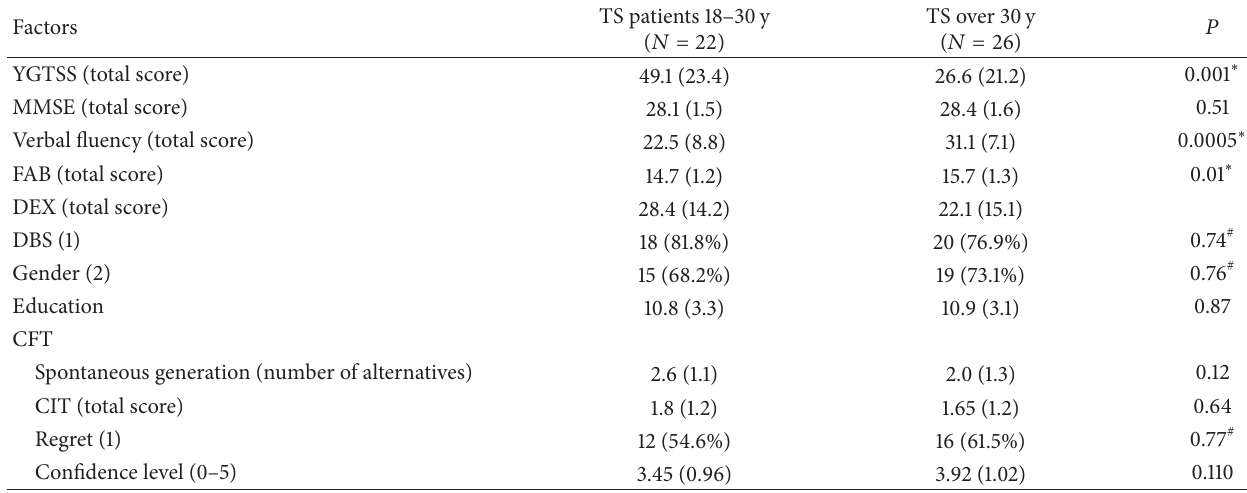
Table 4: Differences between under 30 years old and over 30 years old TS